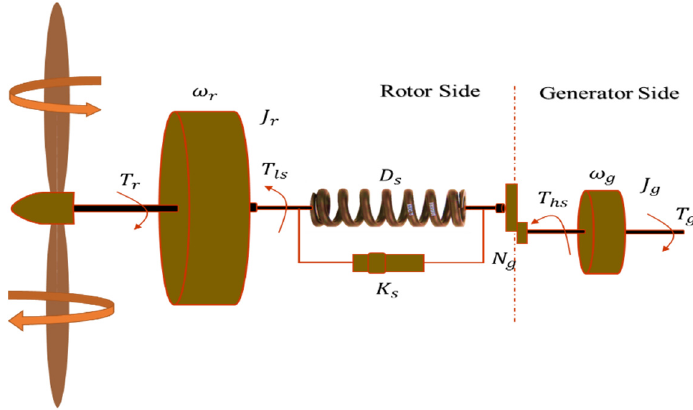
Figure 2. Two mass-model structure of considered wind turbine (WT).